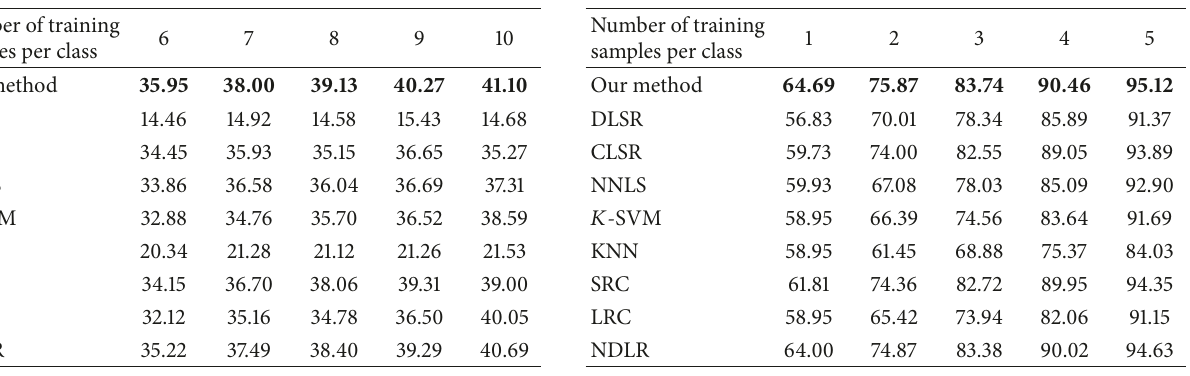
Table 4: Accuracies (%) of different methods on the AR